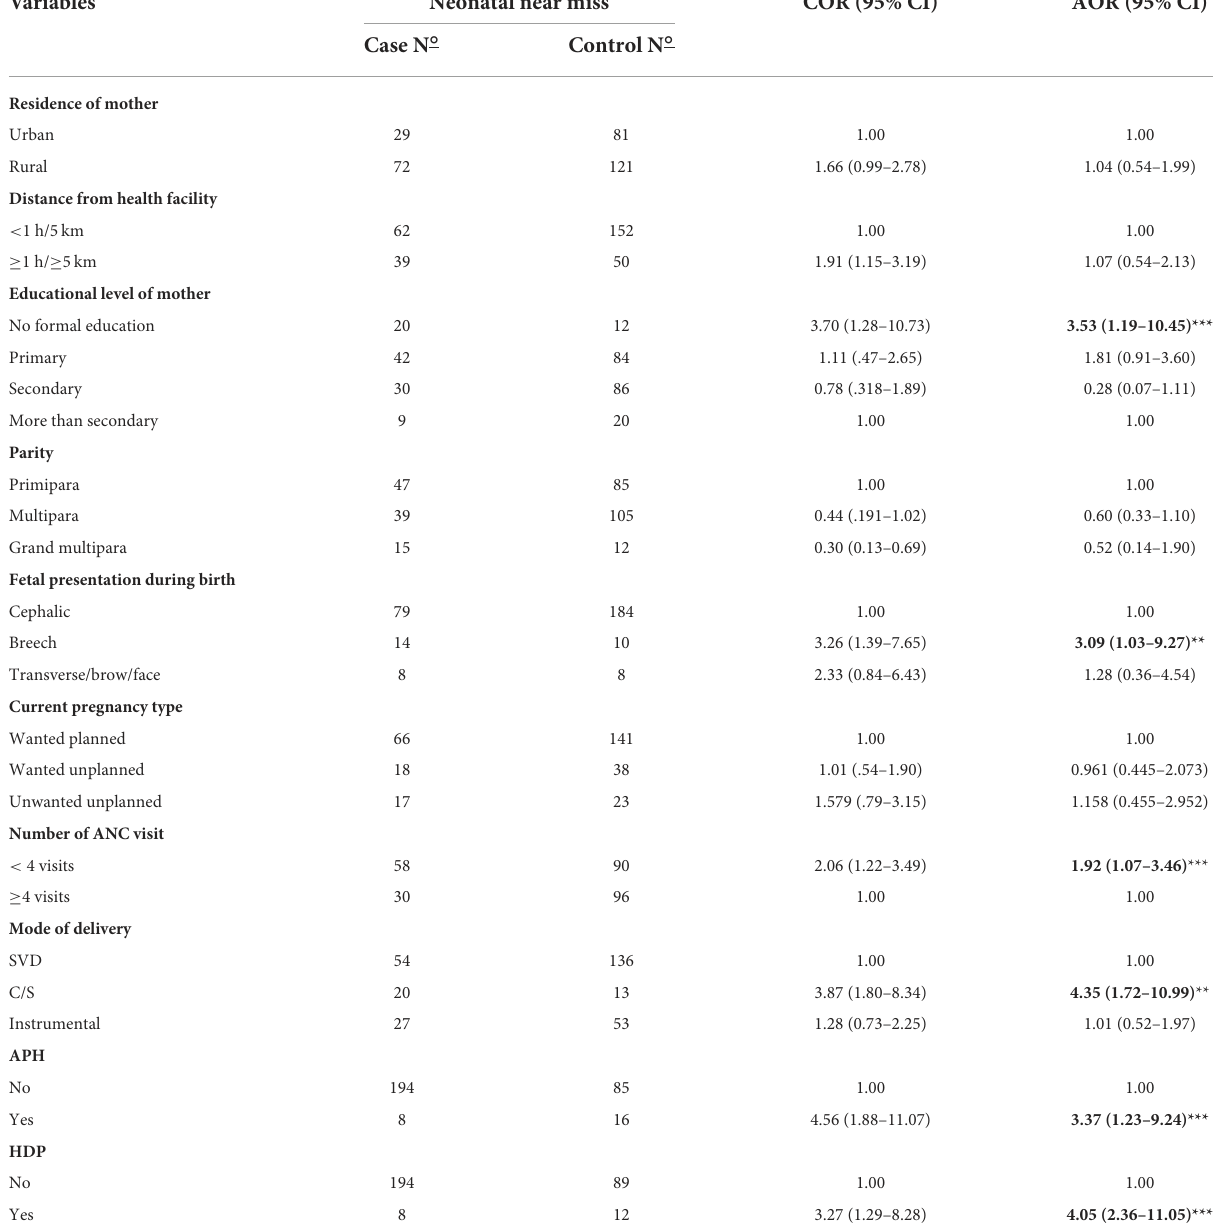
TABLE 7 Determinants of NNM among neonates admitted ( n = 303) to public hospitals of Ilu Abba Bor Zone, 2020.